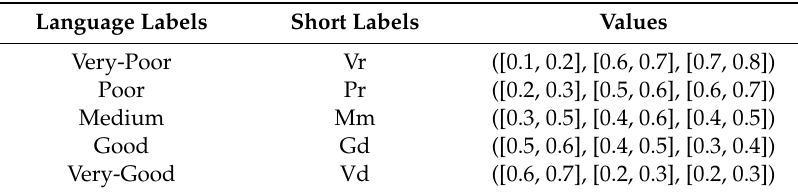
Table 1. Language